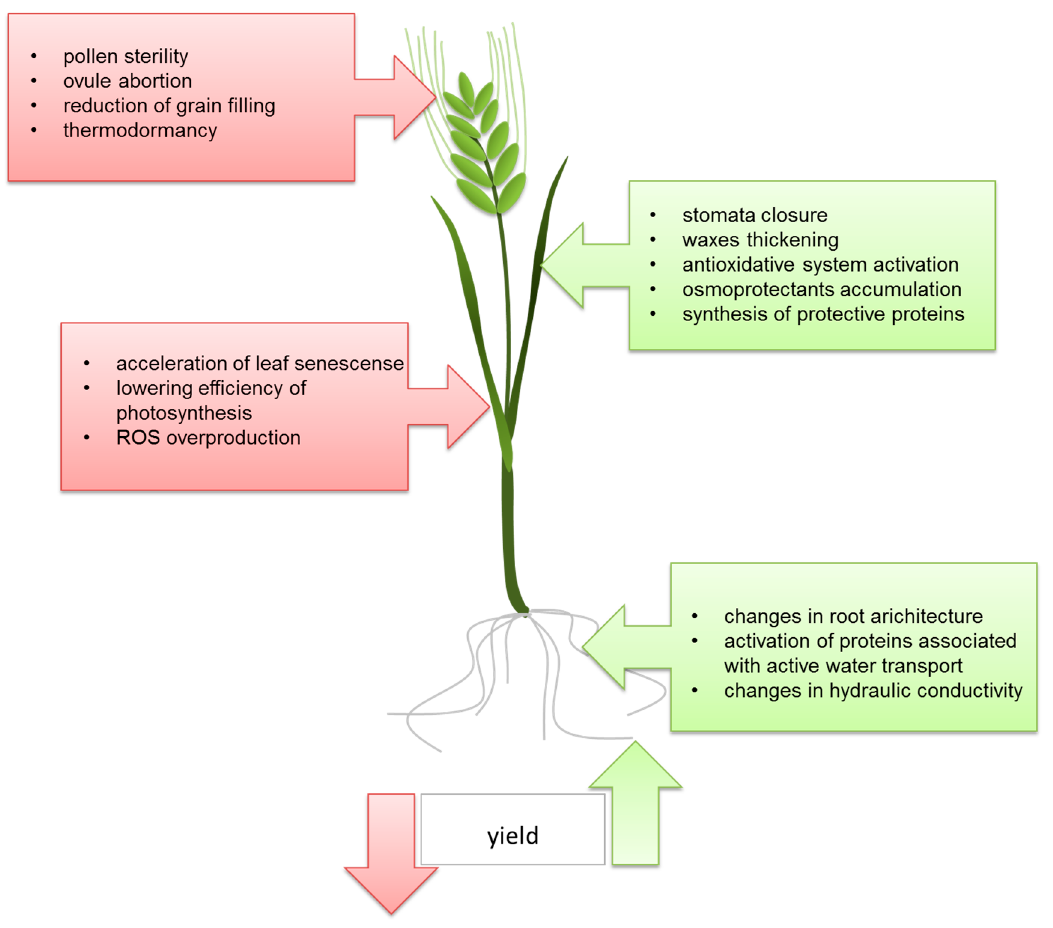
Figure 3. Overview of common ABA-related responses of cereals to abiotic stresses.